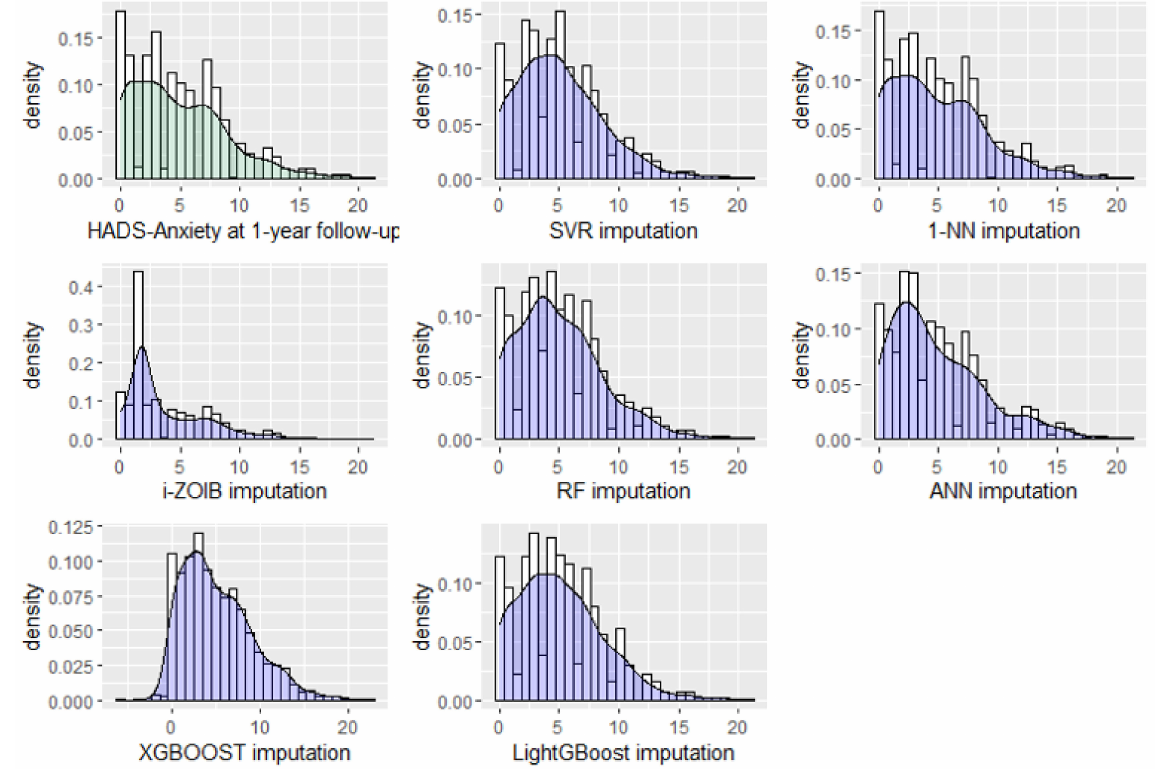
Figure 11. Observed HADS- A score distribution at follow-up ( green ) and different imputed distributions after having applied the imputation methods ( purple